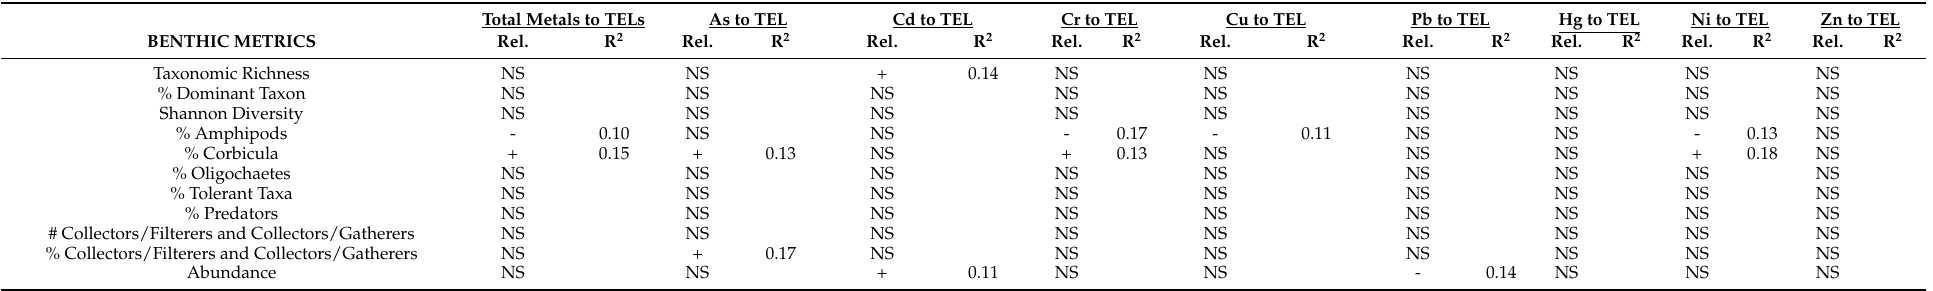
Table 1. Results of univariate linear regression models of benthic metrics versus metals to TEL ratios for sediments from the Cache Slough in the combined 2012, 2013, and 2014 data set, indicating the type of the relationships (+ = direct; - = inverse) and R 2 values for significant relationships ( α = 0.01; NS = not